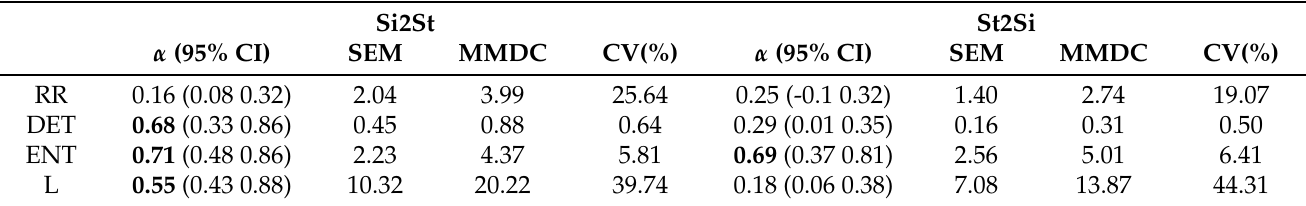
Table 2. Reliability analysis of the RQA measures in the activities of Si2St ( n = 10) and St2Si ( n = 18) for RoomSet2 . Si2St St2Si α (95%